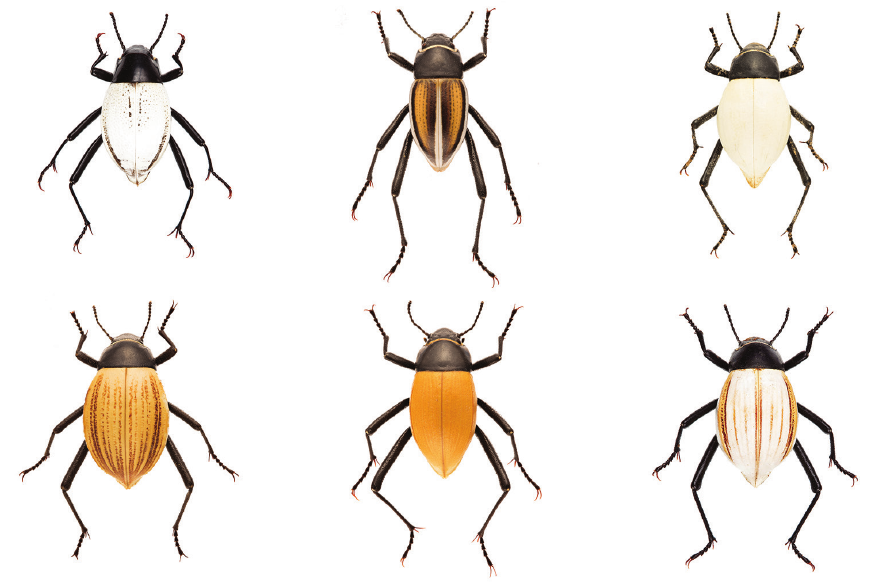
Figure 1. Color variation among members of the ‘white’ Onymacris clade, as represented by: (top row, left to right) Onymacris bicolor , O. marginipennis , O. candidipennis , and (bottom row, left to right) O. langi visseri , O. langi cornelii , and O. langi meridionalis